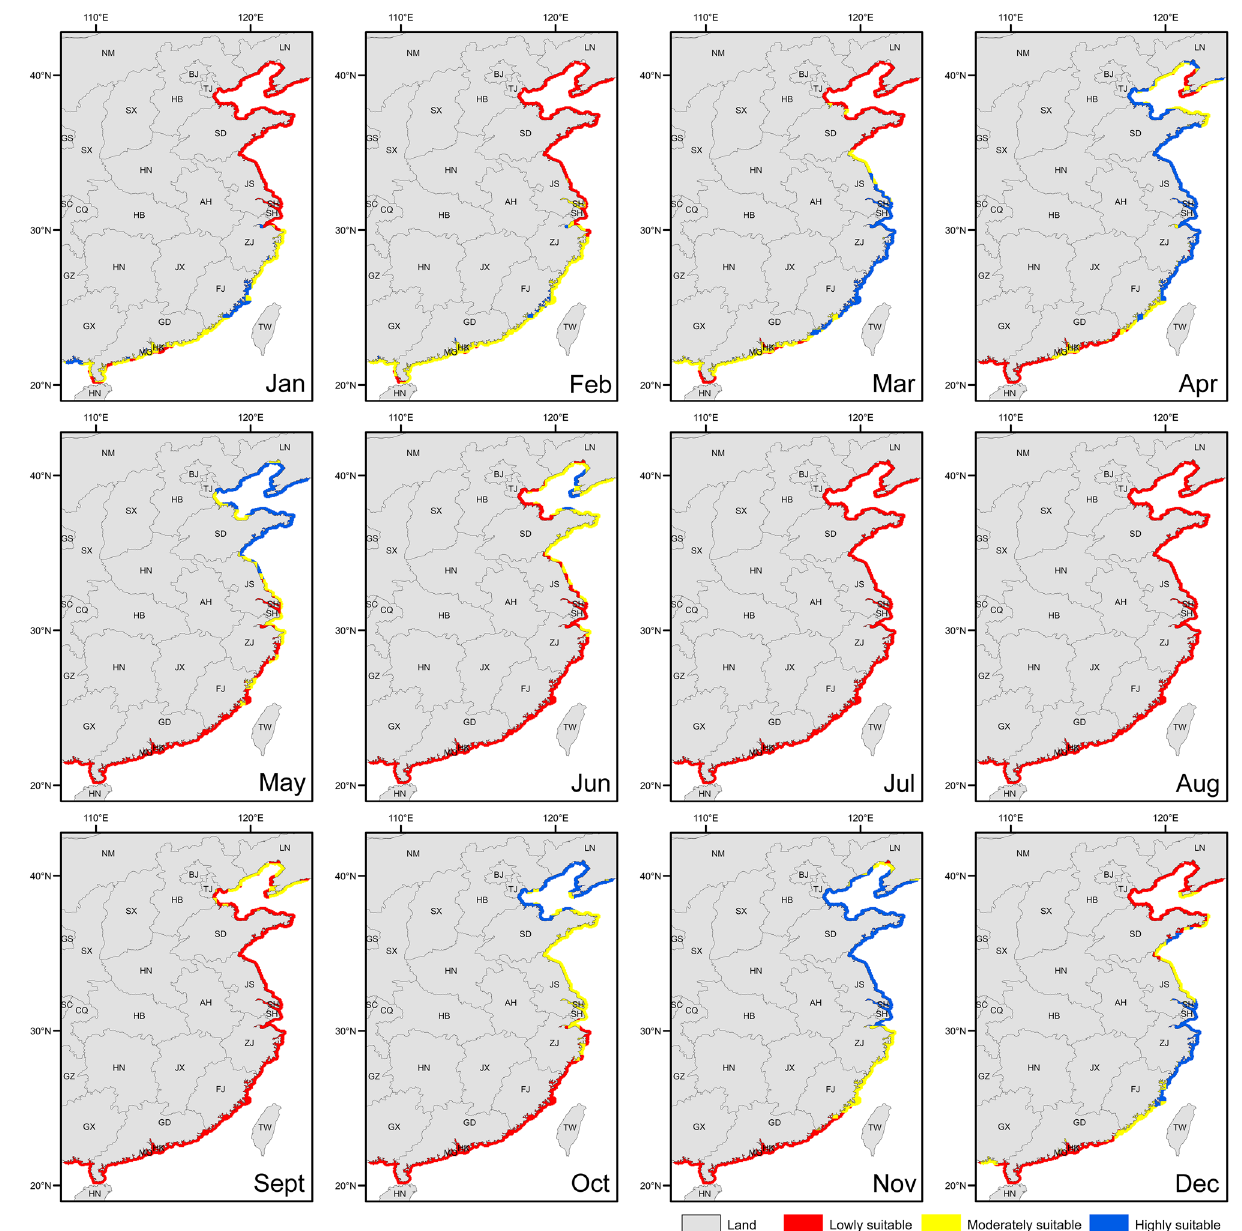
Figure 4. Site suitability for Strongylocentrotus intermedius aquaculture in China. The blue represents the areas that are highly suitable for S. intermedius aquaculture. The yellow indicates that the suitability index is medium. The red indicates that the suitability index is